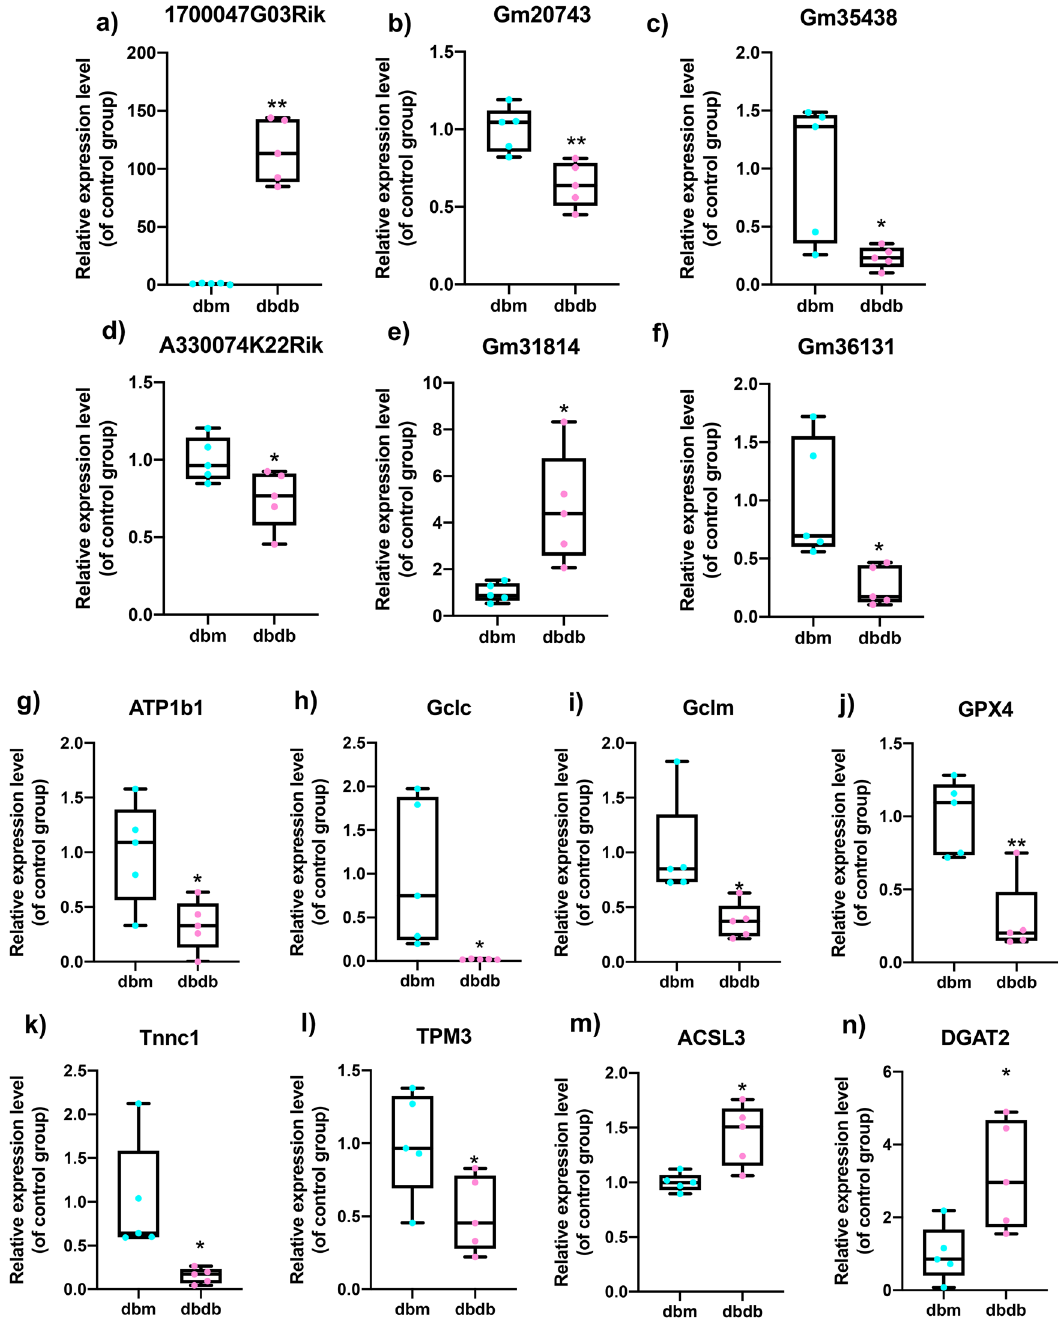
Fig. 4 Validation of the expression of dif-lncRNAs and dif-mRNAs in db/db and db/m mice. The relative expression of dif-lncRNAs (|log2 FC | > 1, expression >2 and q -value <0.01) was detected by RT-qPCR in GAS of db/db and db/m mice ( a – f ). The relative expression of closely related dif-mRNAs involved in signi fi cant pathways was detected in GAS of db/db and db/m mice ( g – n ) ( n = 5). Data were expressed as mean ± S.D. * P < 0.05 ** P < 0.01. Note: RT-qPCR: Real-Time Quantitative